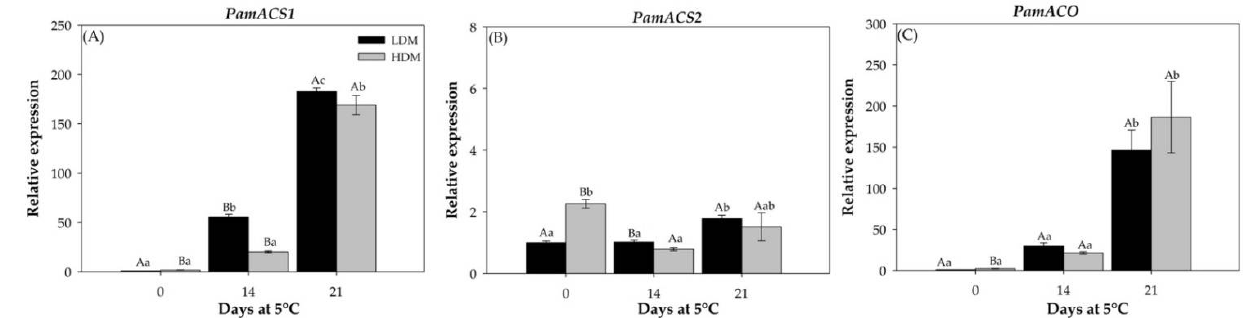
Figure 6. Relative expression analyses of ethylene synthesis genes in “Hass” avocado at the moment of 1–MCP application. ( A ) Relative expression of PamACS1 , ( B ) Relative expression of PamACS2 . ( C ) Relative expression of PamACO . The transcript accumulation of genes was determined by qPCR. Expression was normalized to the housekeeping gene PamTCPB , and the expression is relative to that in LDM fruit (day 0). Bars represent the means of three replicates ± SE. Different lowercase and capital letters indicate a significant difference among treatments and maturity stages by LSD analysis ( p -value < 0.05).